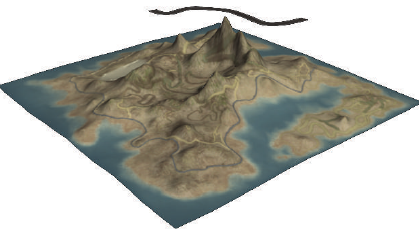
Figure 6: Input terrain and track